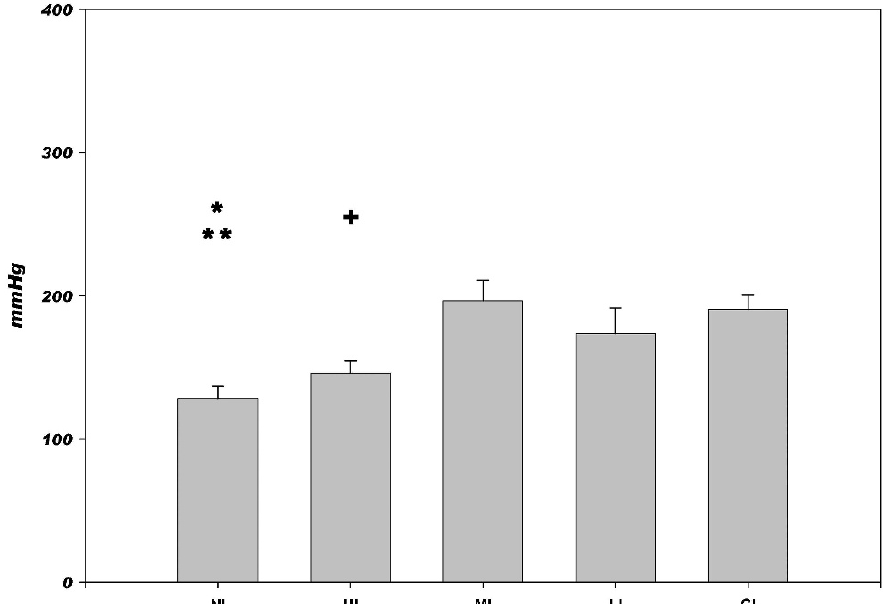
Figure 3 - Bursting pressure in ischemic (high-risk) colon anastomoses in rats. * p , 0.01 vs. HI and CI; ** p , 0.05 vs. LI; + p , 0.05 vs. HI